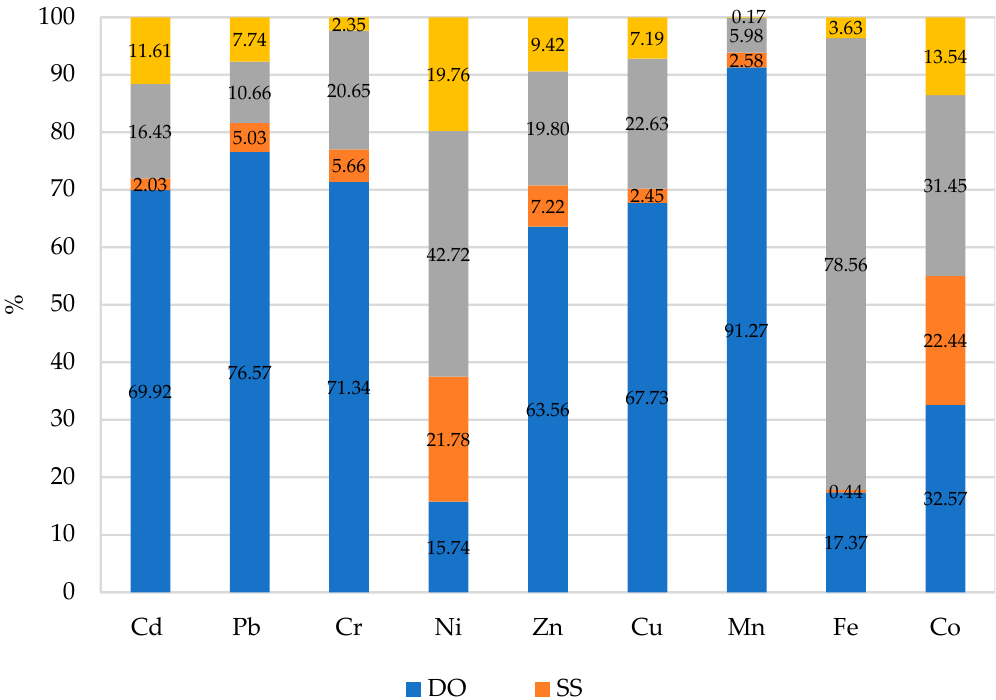
Figure 2. Percentage contribution of variable factors according to the content of trace elements in aboveground parts of oat ( Avena sativa L.): DO—diesel oil dose, SS—sewage sludge dose.